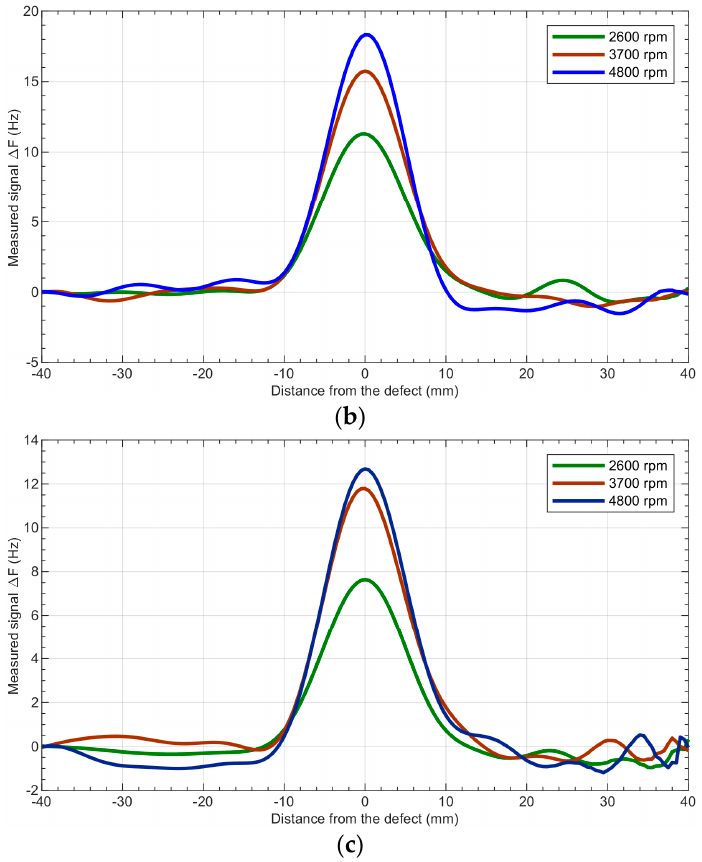
Figure 10. Results of the measurements acquired from the aluminum sample with notches having depths of ( a ) 15 mm, ( b ) 6 mm, and ( c ) 4 mm—comparison of the deviation of the fundamental frequency for different rotational speeds of the head: 2600 rpm, 3700 rpm, and 4800 rpm.